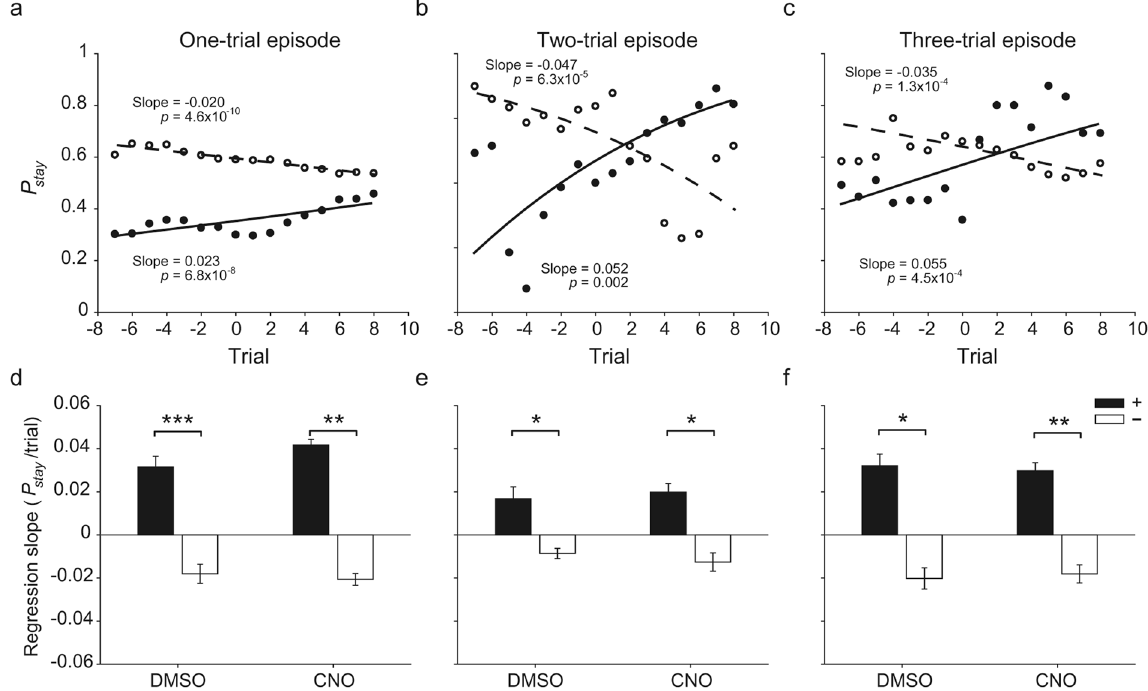
Figure 5. Analysis results related to episodic control of choice behavior. ( a – c ) Examples showing the probability to repeat the previous choice ( P stay ) following a specific pattern of past choices and their outcomes during 10 trials before and after a block transition (trial 0). Circles represent P stay following one type of episode during DMSO sessions of a particular animal group (five-trial moving average) and lines were determined by logistic regression. Filled and open circles denote episodes where the last choice corresponds to the higher- and lower-reward-probability target, respectively, after block transition. Shown are P stay following [( + , 0)] (filled circle) and [( − , 0)] (open circle) (one-trial episode in CaMKIIa-Cre mice), ( a ) [( + , 0) ( + , 1)] (filled circle) and [( − , 0) ( − , 1)] (open circle) (two-trial episode in Grik4-Cre mice), ( b ) and [( + , 0) ( + , 0) ( + , 0)] (filled circle) and [( − , 0) ( − , 0) ( − , 0)] (open circle) (three-trial episode in Rbp4-Cre mice), ( c ) where ‘ + ’ and ‘ − ’ denote choosing the targets with higher and lower reward probabilities after block transition, respectively, and ‘1’ and ‘0’ indicate positive and negative outcomes, respectively. The slopes of the logistic regression were significantly different from zero as indicated by p -values. ( d – f ) Group data. Shown are mean ( ± SEM across different animal groups) slopes of the logistic regression for all equal-length episodes where the last choice corresponds to the higher (filled bar)- or lower (open bar)-reward-probability target after block transition under DMSO or CNO condition ( d , one-trial; e , two-trial; f , three-trial episodes). * p < 0.05, ** p < 0.01, *** p < 0.001 (paired t